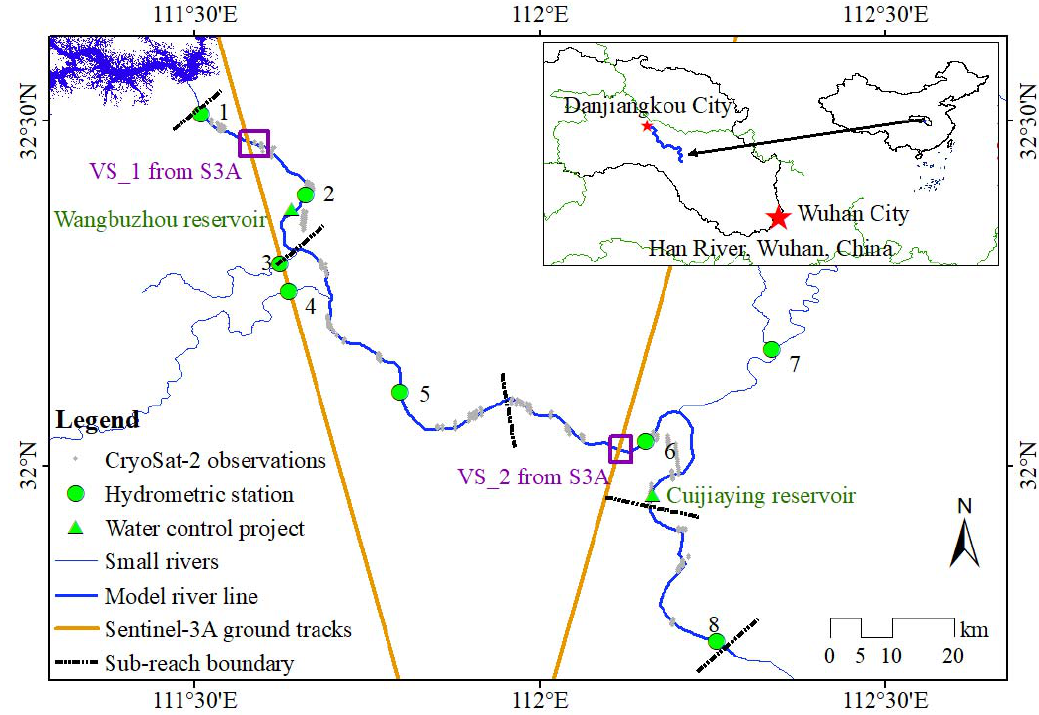
Figure 1. Map of the study site. The study reach (from Huangjiagang to Yicheng stations) belongs to the middle stream of the Han River, in China. Four sub-reaches based on the distribution of hydrometric stations and river morphology are established for a spatially variable roughness scheme. Table 1. Summary of the hydrometric stations. Q denotes discharge; W denotes water